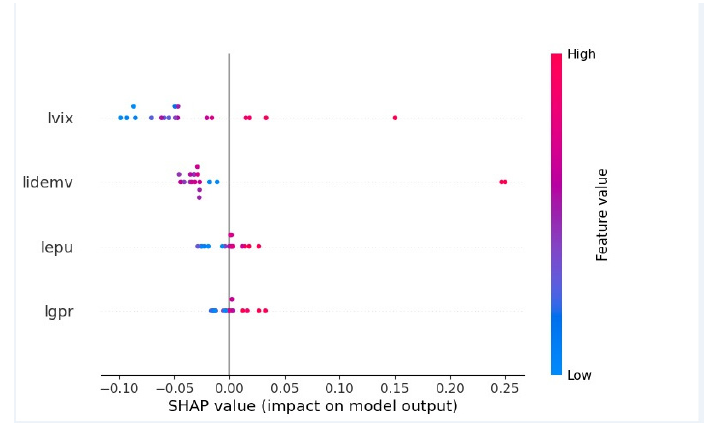
Figure 11. Feature importance before the pandemic—SVM model (Weekly frequency).